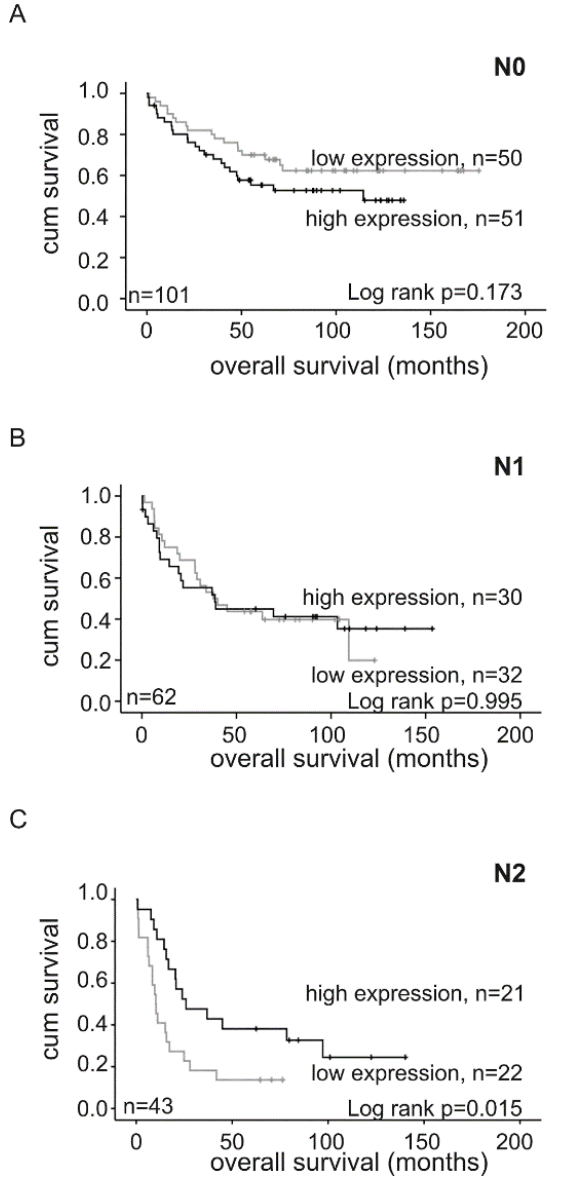
Figure 5. Low ORP3 mRNA levels associate with reduced survival of advanced nodal metastasis of colon cancer patients. Relative quantification of ORP3 RNA expression in N0 (low ORP3 expression: 24 female, 26 male and high ORP3 expression: 25 female, 26 male) ( A ), N1 (low ORP3 expression: 14 female, 18 male and high ORP3 expression: 15 female, 15 male) ( B ), and N2 (low ORP3 expression: 9 female, 13 male and high ORP3 expression: 9 female, 12 male) ( C ) classified tumors of colon cancer patients was performed by qRT-PCR using ORP3 specific primers. HPRT and β-ACTIN were used as reference genes. Kaplan–Meier survival plots were generated using IBM SPSS Statistics 25. Black: high ORP3 expression levels; grey: low ORP3 expression levels.